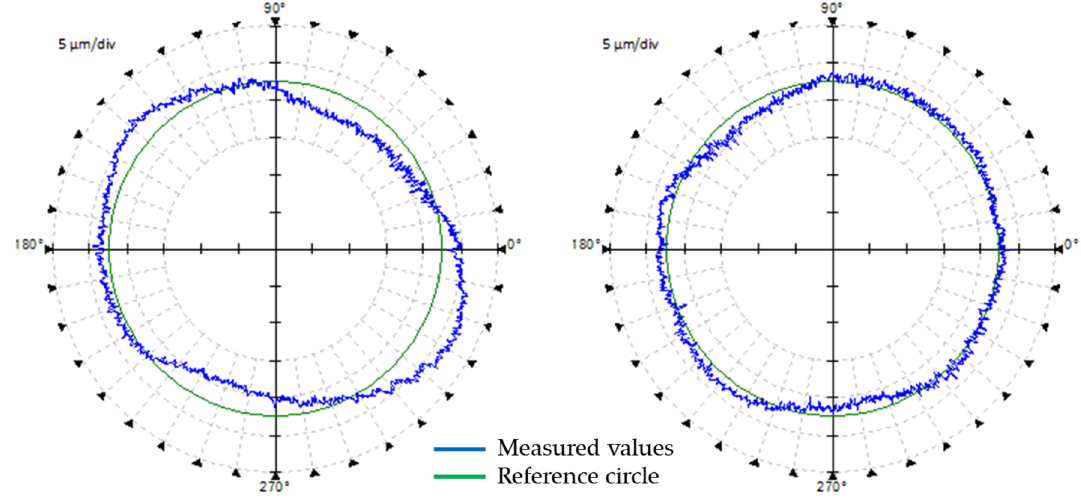
Figure 15. 200 mm outer diameter for TH1 and TH2 in position 04.